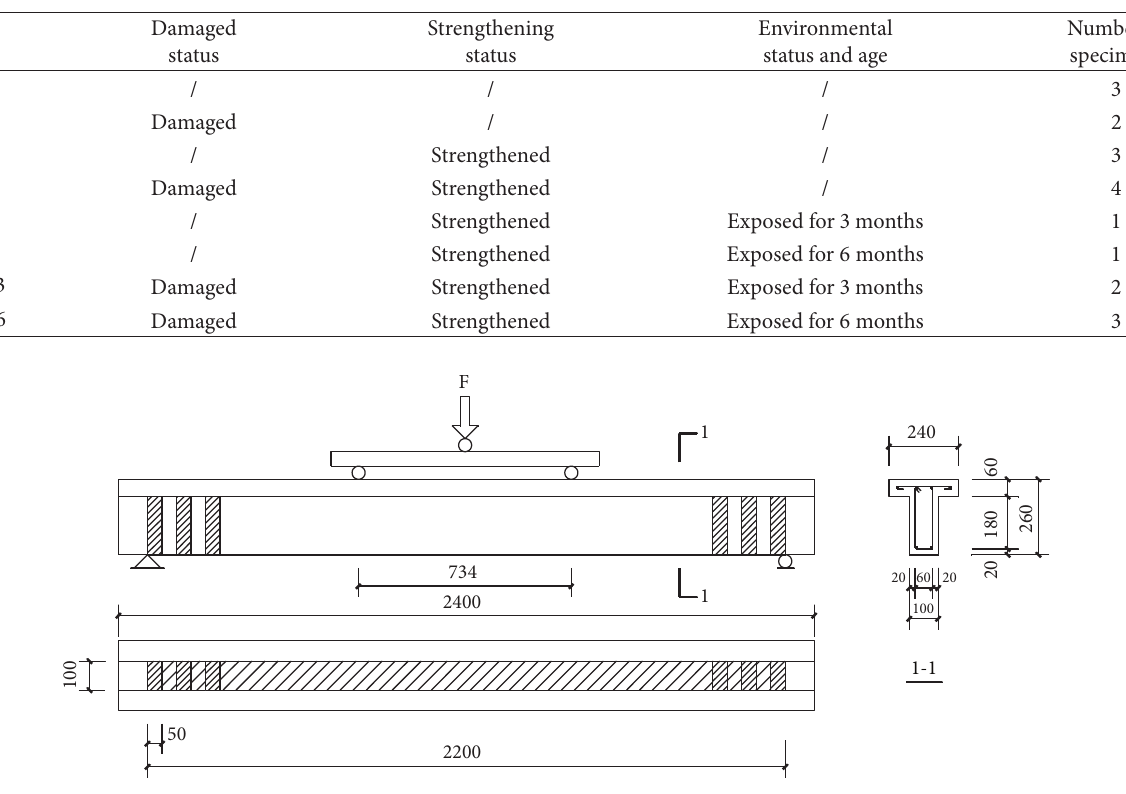
Table 1: Specimen details.